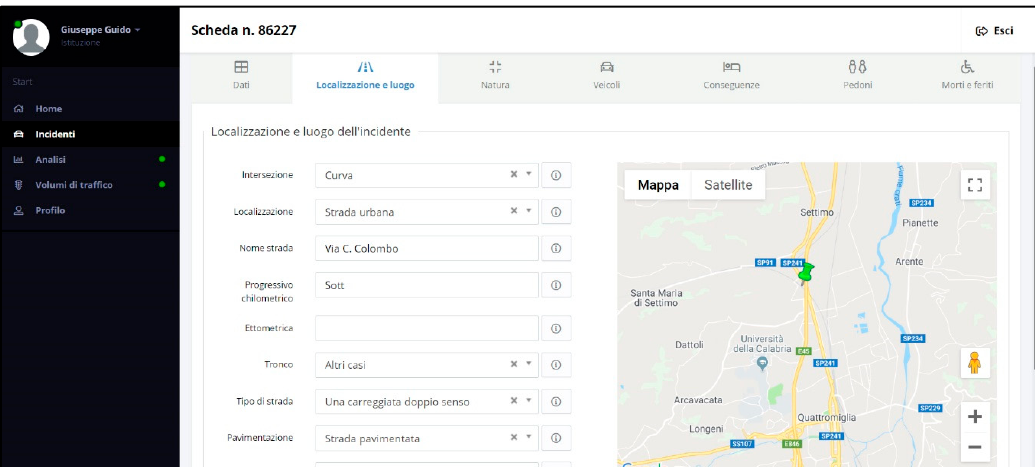
Figure 1. Sample of accident occurrence locations from Regional Center for Road Accidents’ Data Collection of the Calabria Region (CRISC) website.